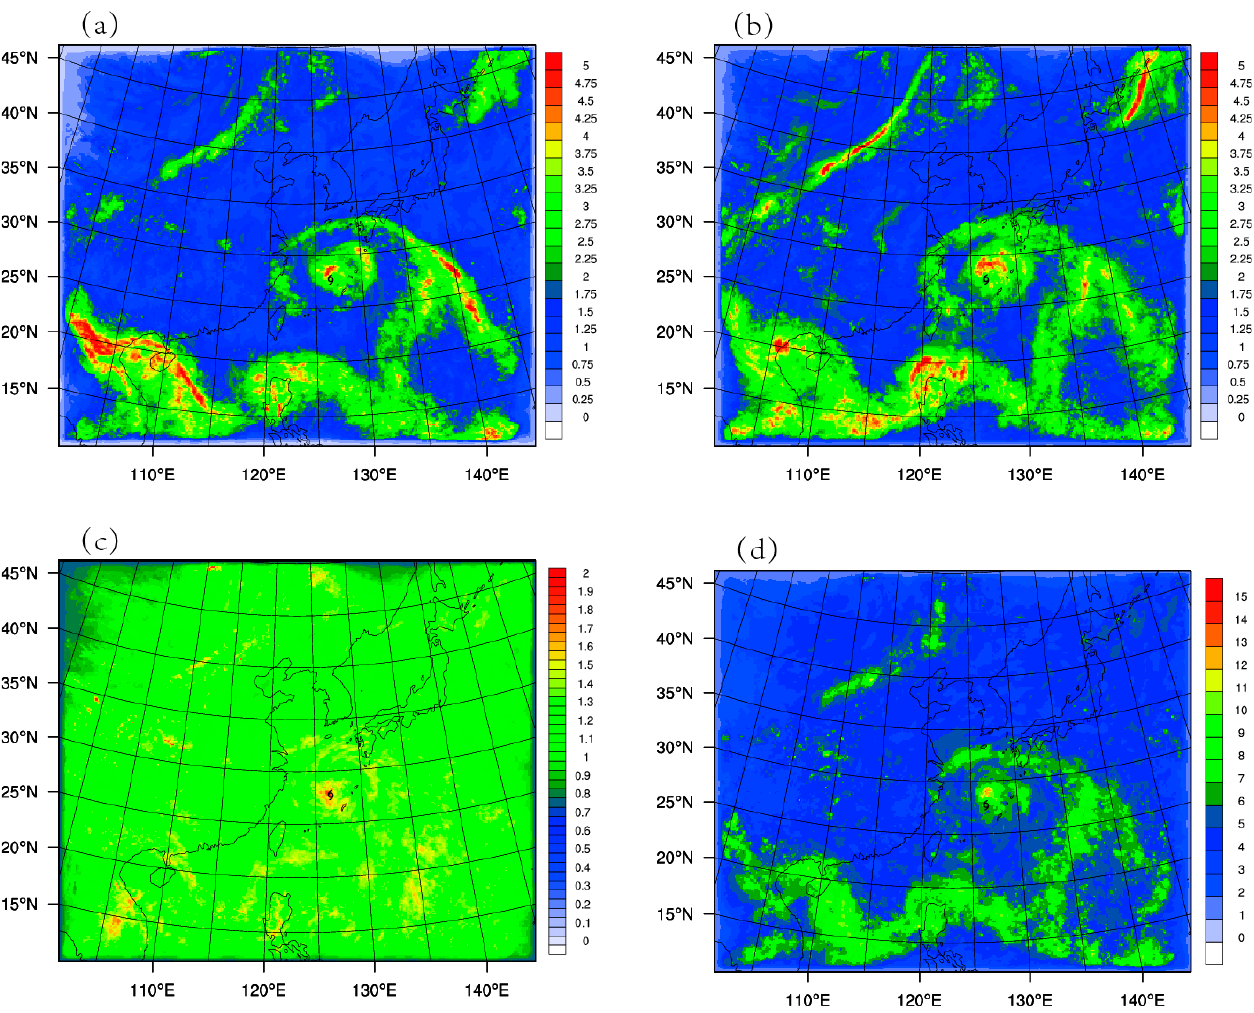
Figure 7. Ensemble spread of ( a ) zonal wind (unit: m/s), ( b ) meridional wind (unit: m/s), ( c ) temperature (unit: K), and ( d ) geopotential height (unit: gpm) at 0600 UTC on 21 July 2018 at 500 hPa.